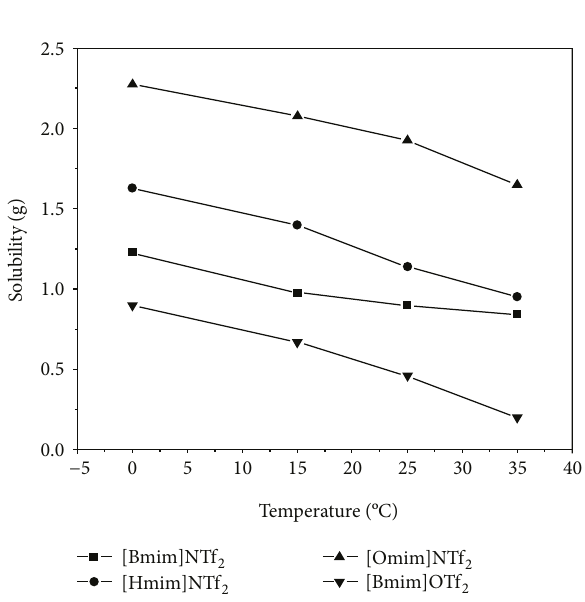
Figure 1: Solubility of SiCl